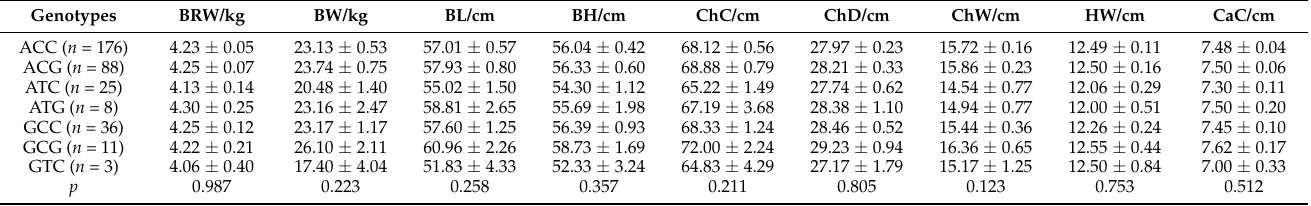
Table 6. Association analysis of haplotypes in SSTR1 with growth traits of Hulun Buir sheep at birth and weaning 1 .